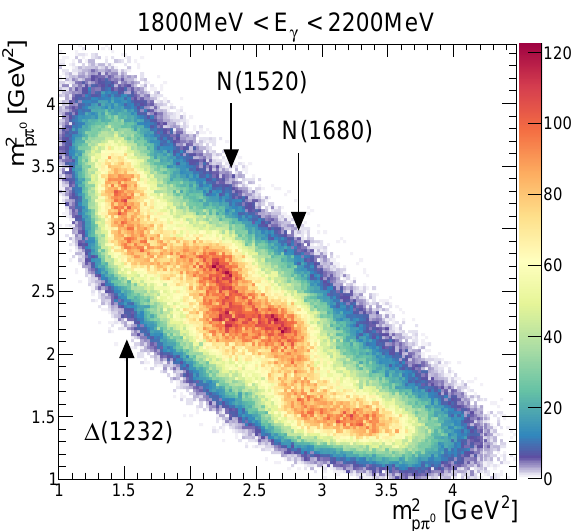
Figure 9. A Dalitz plot is depicted for the reaction γ p → p π 0 π 0 for an energy range of 1800 MeV < E γ < 2200 MeV. The hori- zontal and vertical bands indicate the intermediate states.